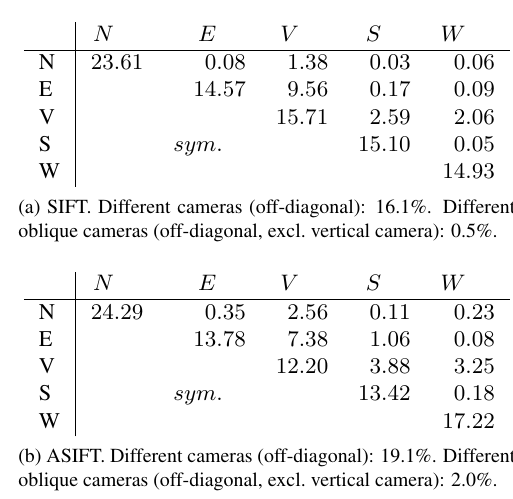
Figure 1: Histograms of tie point manifolds after reconstruction, SIFT vs. ASIFT. The maximum possible manifold would be 25 at the very center of the block (Jacobsen and Gerke, 2016).